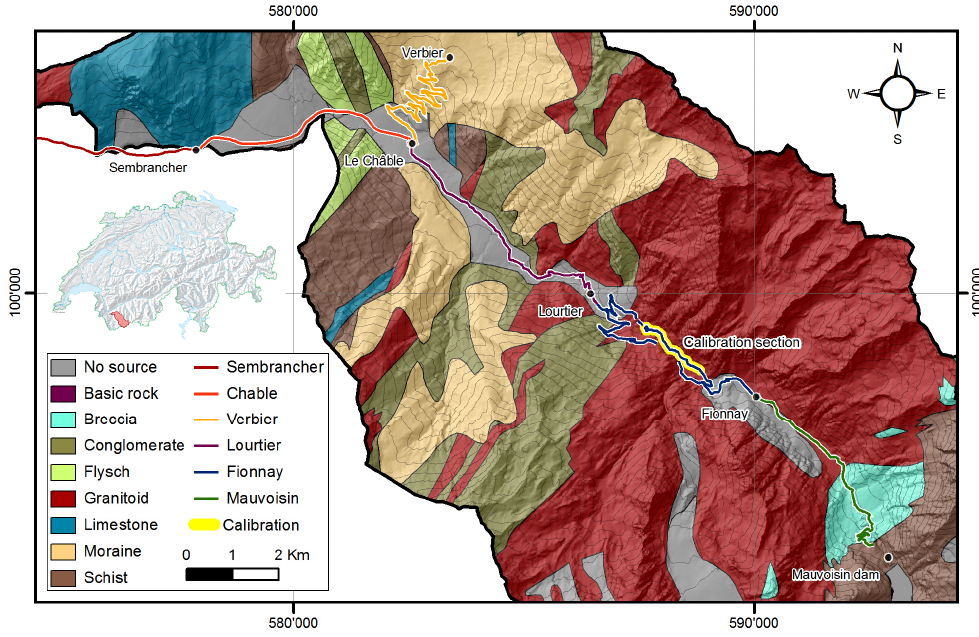
Fig. 6. Studied road sections and homogenous morphometric areas of the Bagnes Valley, located in the Swiss Alps, classified according to the swiss national geological atlas and the Vector25 (©swisstopo). They were identified differentiating daily traffic and mean velocities along the roads. The road section used to calibrate the rockfall hazard assessment is located between the second gallery after Lourtier and Le Plamproz (section underlined in yellow), where the rockfall activity is high, as shown in Fig. 1. (Hillshade and 10m isohypses: ©2008 swisstopo).